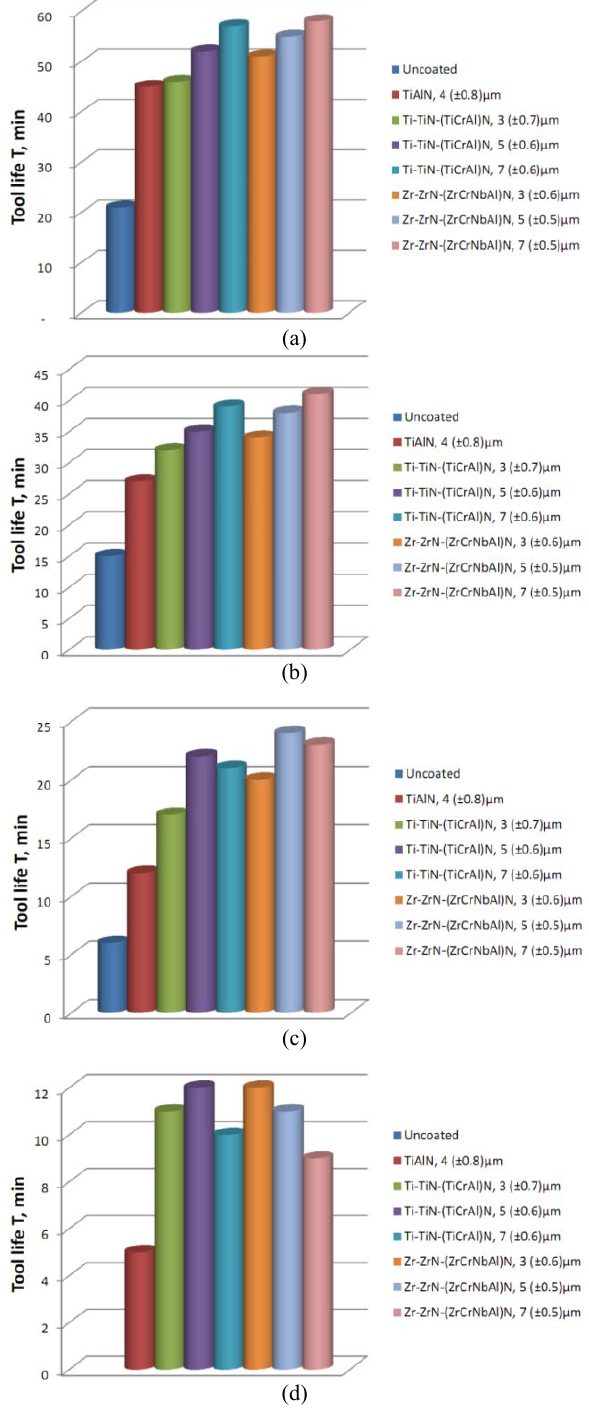
Fig. 3. Tool life of tools with coatings under study and of uncoated tools at cutting speeds of vc = 250 (a), 300(b), 350 (c) and 400 (d) mmin-1(f = 0.2 mm/rev; аp = 1.0 mm, longitudinal turning of steel